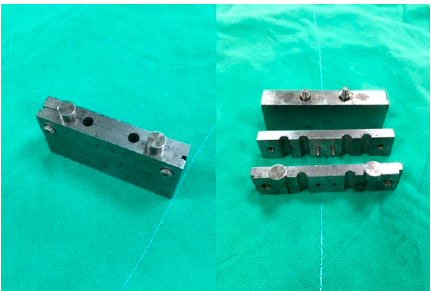
Figure 1. Mold used for compression molding of the antifungal-agent-containing beads. Table 1. Composition of the fluconazole-loaded Poly( d , l -lactide- co -glycolide) beads. PLGA / Drug